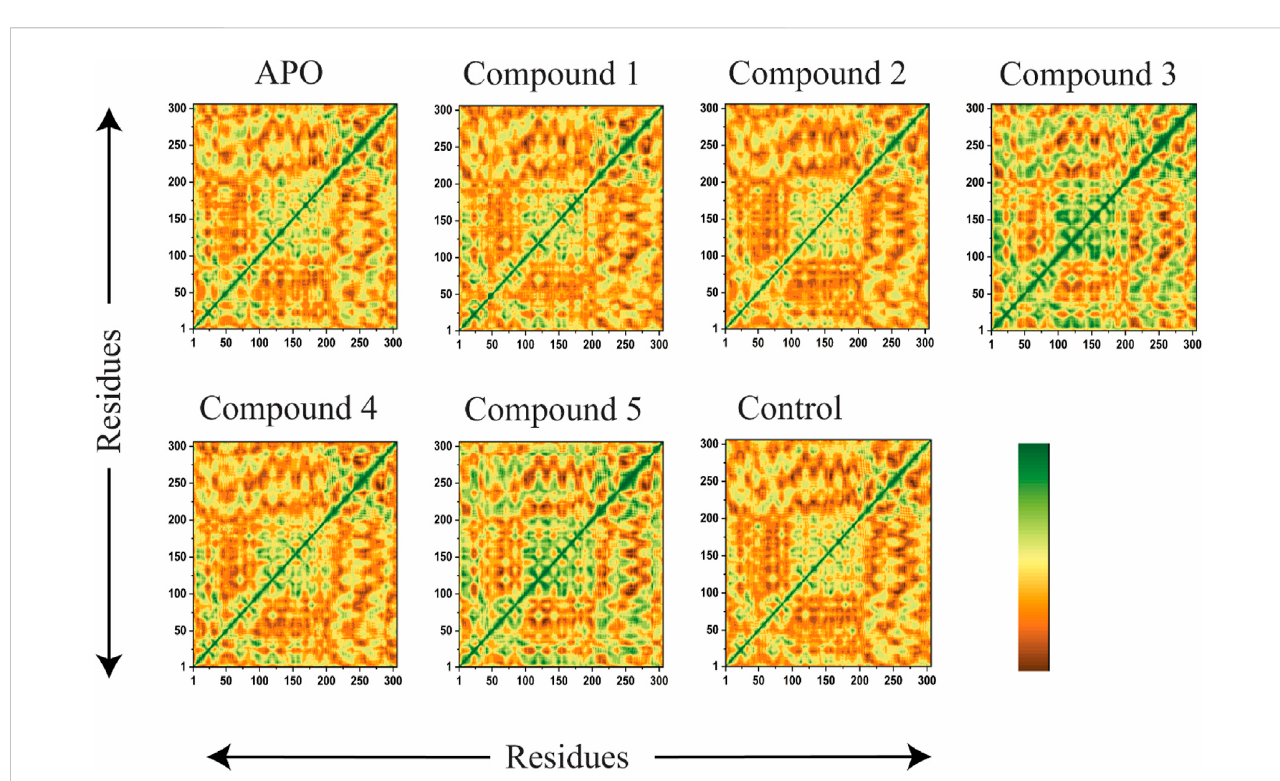
FIGURE 11 DCCMoftheAPOstate,Compound1,Compound2,Compound3,Compound4,Compound5,andivermectin(control)boundto3CL PRO .Thepositively correlated movement is represented by green color, while negatively correlated motion is indicated by deep brown